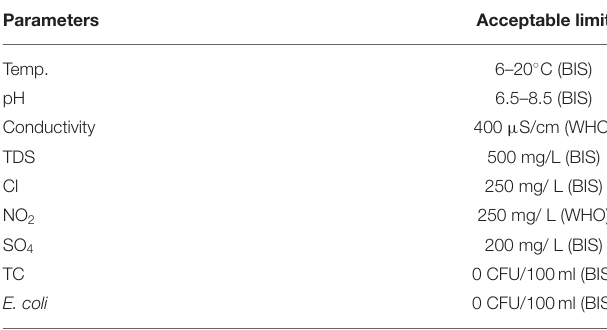
TABLE 3 | Acceptable limit of physicochemical parameters in drinking